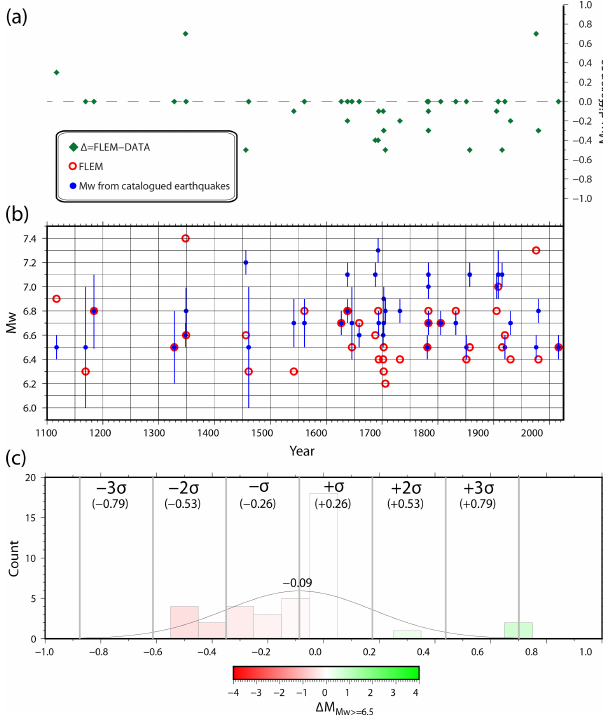
Figure 13. (a) Temporal series (since 1000CE) of the difference be- tween FLEMs (from class A faults) and spatially coincident (same cell) historically/instrumentally catalogued magnitudes of earth- quakes (only M w ≥ 6 . 5). (b) In blue, temporal series of magnitudes from catalogued historical or instrumental earthquakes ( M w ≥ 6 . 5, 1000–2017 period). Blue vertical bars are for magnitude uncer- tainty. In red, FLEM values from the same cells hosting the cat- alogued historical or instrumental earthquakes drawn in blue. (c) Histogram of the difference between FLEMs (from class A faults) and spatially coincident (same cell) historically/instrumentally cat- alogued magnitudes of earthquakes ( M w ≥ 6 . 5, 1000–2017 period). Mean =− 0.09; standard deviation σ = 0.26. See Fig. 12 for the in- terpretation of red vs. green portions of the